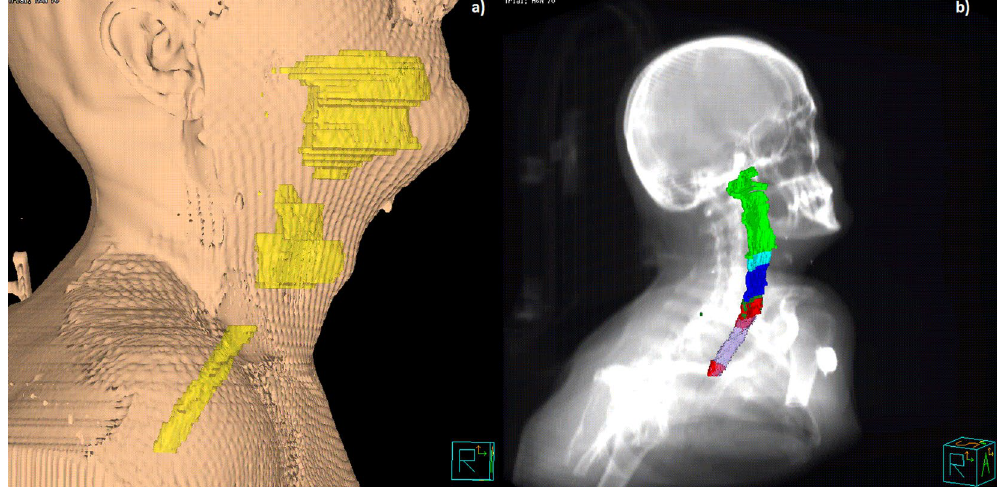
Figure 4. Volume rendering of head and neck structures in the common coordinate system: ( a ) 3D body rendering of the reference patient along with the three structures (yellow) used to derive the registration mask (oral cavity, larynx and esophagus); ( b ) 3D rendering of the superior (light green), middle (cyan) and inferior (blue) pharyngeal constrictor muscles, the cricopharyngeus muscle (forest green) and the cervical esophagus (violet), along with the S 0.05 structure (red), superimposed on the Digital Reconstructed Radiograph.